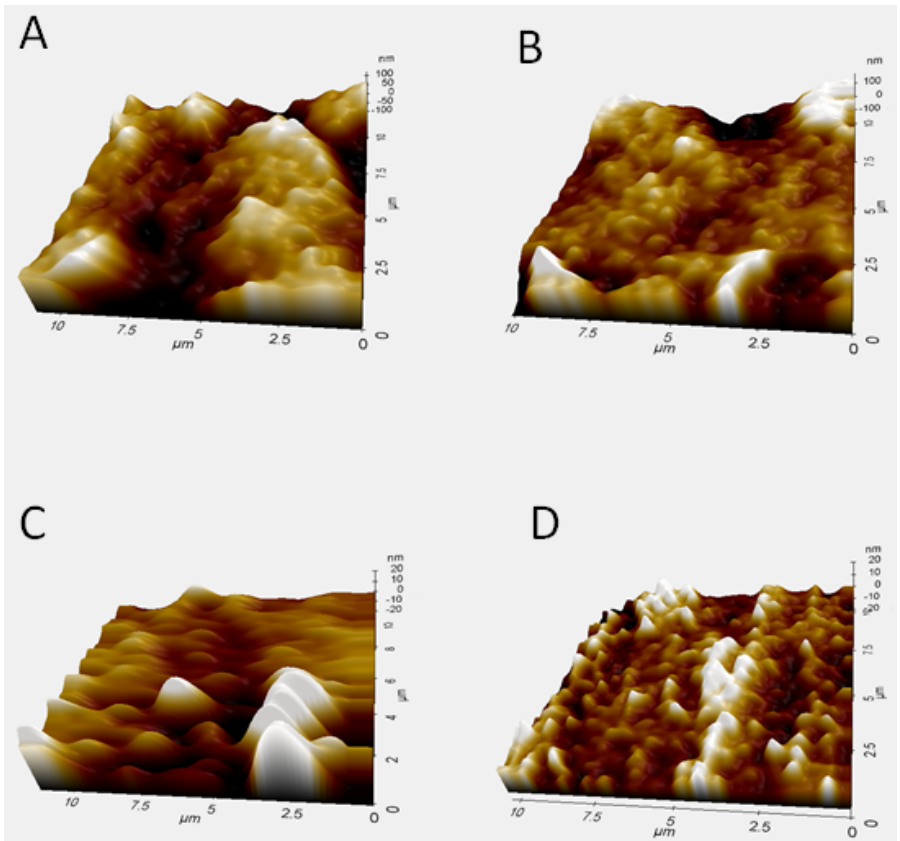
Figure 8. Atomic force microscopy (AFM) images of ( A ) graphite; ( B ) graphite/poly (4-ATP); ( C ) graphite/poly(4-ATP)/EBV1; and ( D ) graphite/poly(4-ATP)/EBV1:EBV2.